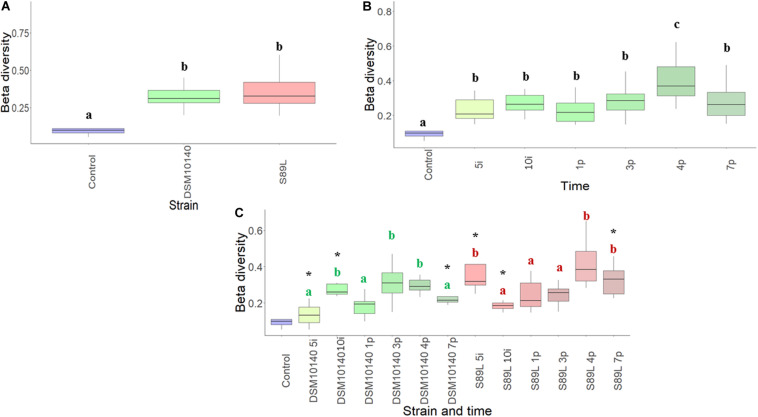
Beta-diversity (Bray–Curtis metrics) of the relative abundance of colonic microbiota samples from mice grouped according to the EPS-strain used for feeding (A), the intervention time (B) and a combination of both EPS-strain and sampling (days) points (C). Different letters indicate statistical differences among the different EPS-strain groups (A) or sampling days (B); in the combination of both factors (C), within each EPS-strain group samples (days) those that do not share a common letter are statistically different (p < 0.05), whereas within each treatment day, the statistical differences between the DSM10140 and S89L groups are marked with an asterisk (*p < 0.05).